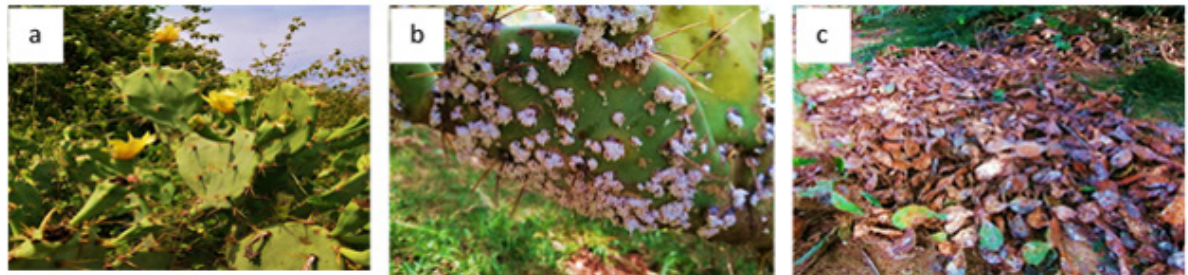
Figure 3: (a) Healthy plant of O. dilleniii , (b) infested cladode with D. opuntiae and (c) dead bushes due to high infestation at Bundala National Park.